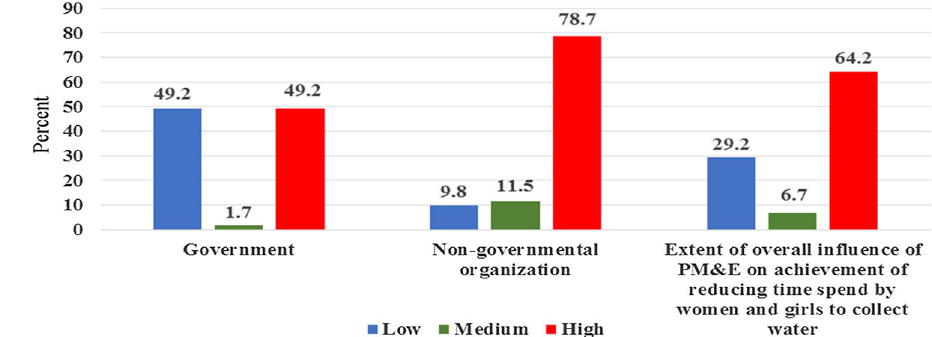
Fig. 6 Effectiveness of PM&E on achievement of reducing time used by women and girls to collect water